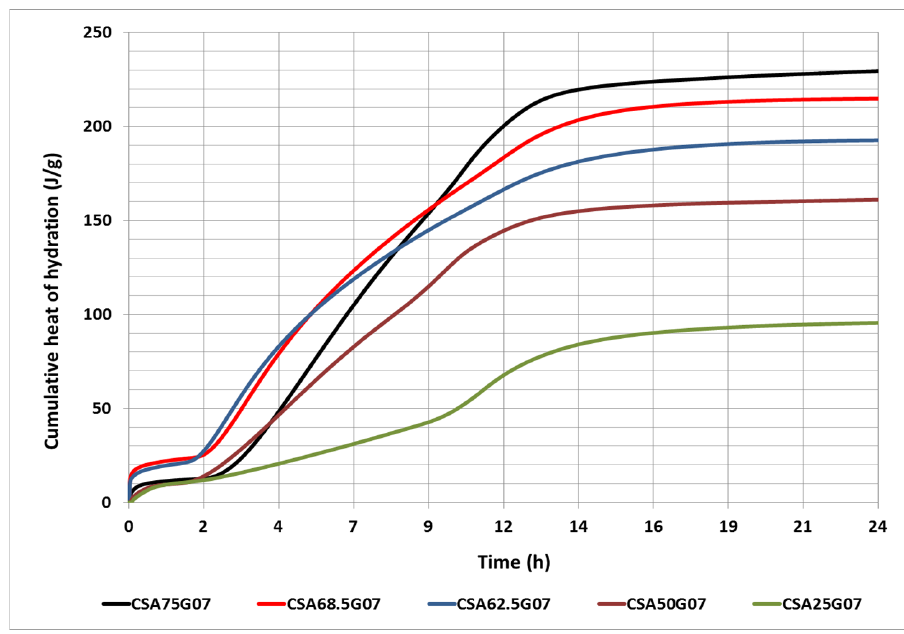
Figure 4. Evolution of the cumulative heat release for the di ff erent cement pastes in 24 h.